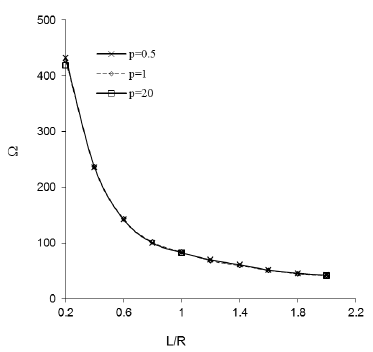
Figure 2: Variation of natural frequency with length-to-radius ratio of FGM cylindrical shell with SS edges (m=1; R/h=500; Type A)